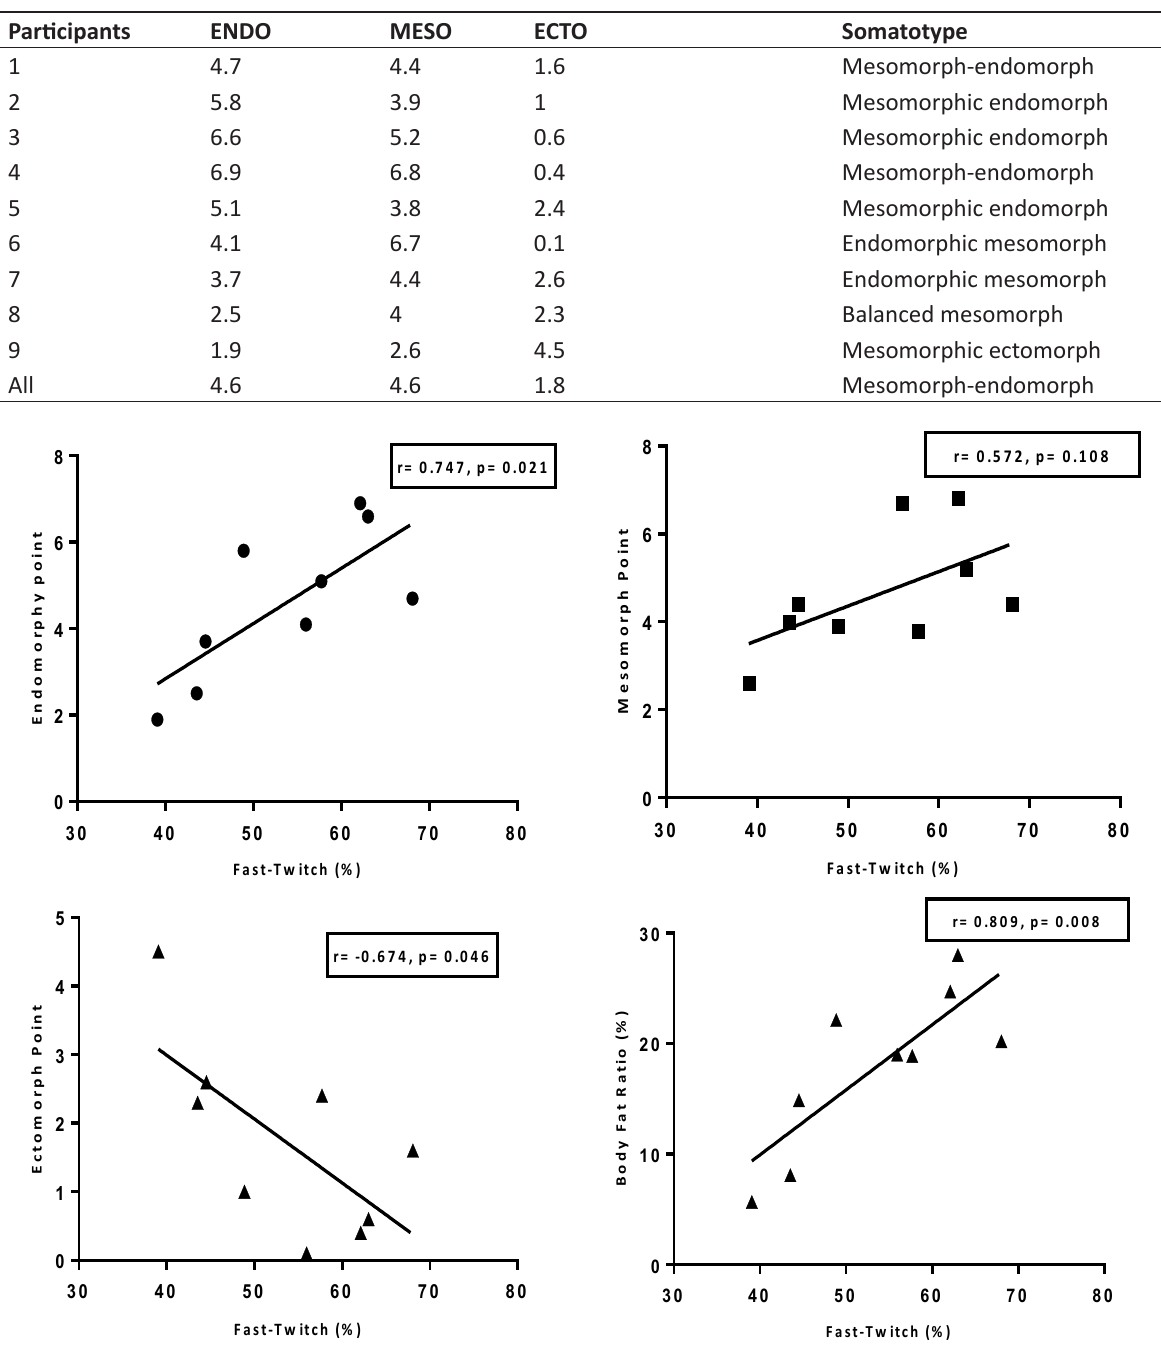
Figure 2. Correlation values between FT fibril percentage and somatotype